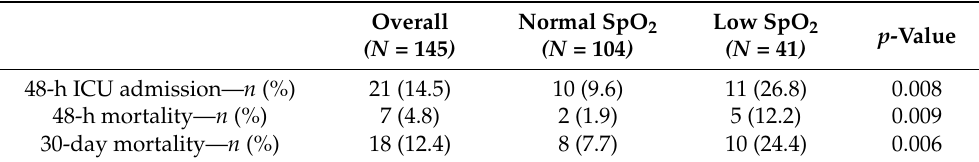
Table 2. Primary and secondary outcomes: group